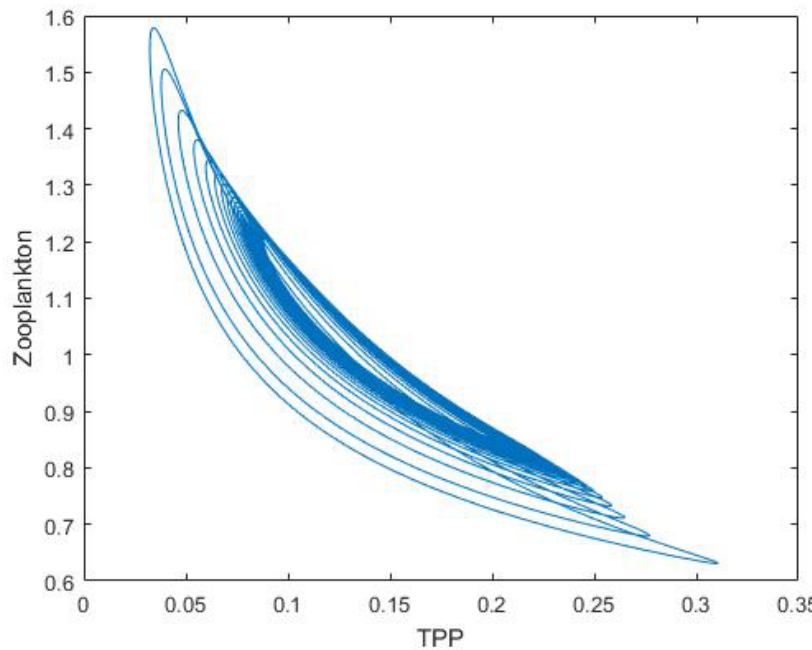
Figure 2. Equilibrium between the TPP and zooplankton populations loses its stability for τ = 0 < τ 0 .